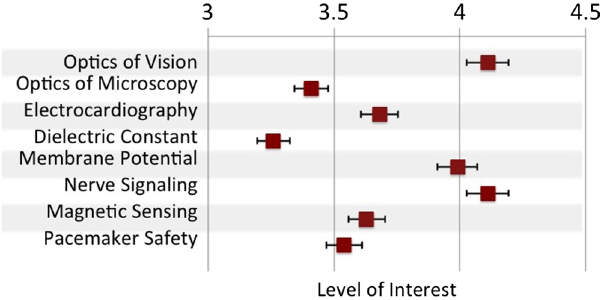
FIG. 2. Students ranked their levels of interest in key biological contexts on a five-point Likert scale. Average results and standard errors are shown for the IPLS course (years 1 – 4, N ¼ 194